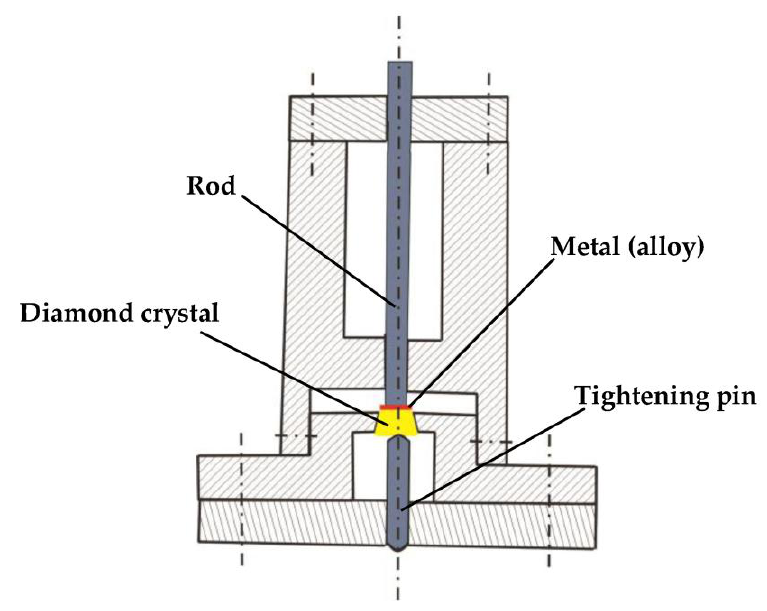
Figure 10. Scheme of the device for determining the strength of the interface between diamond and metal (alloy).